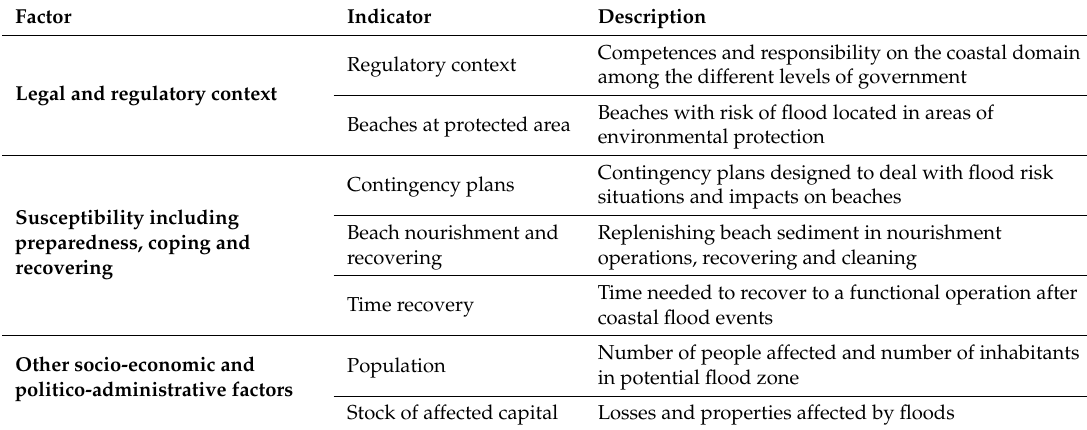
Table 3. Indicators in the socio-economic and political-administrative context.